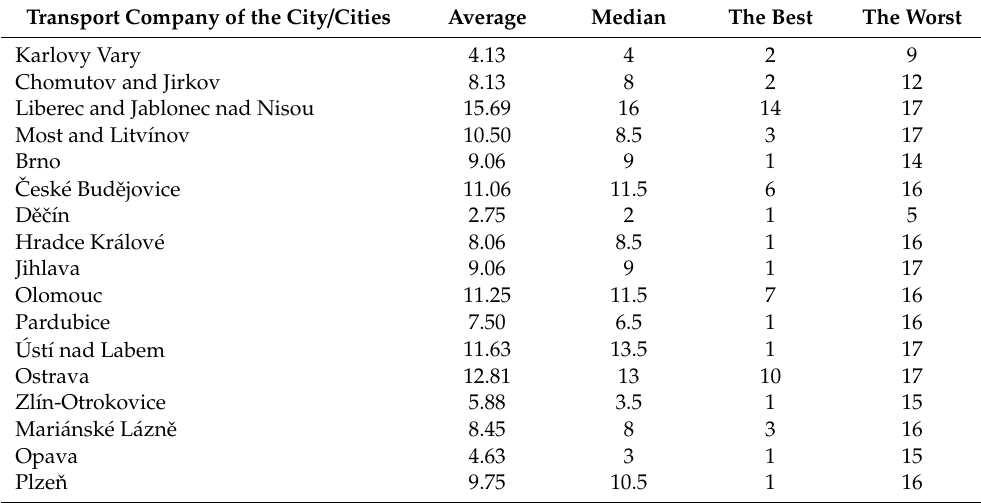
Table 5. Ranking of transport companies within entire monitored period (variant